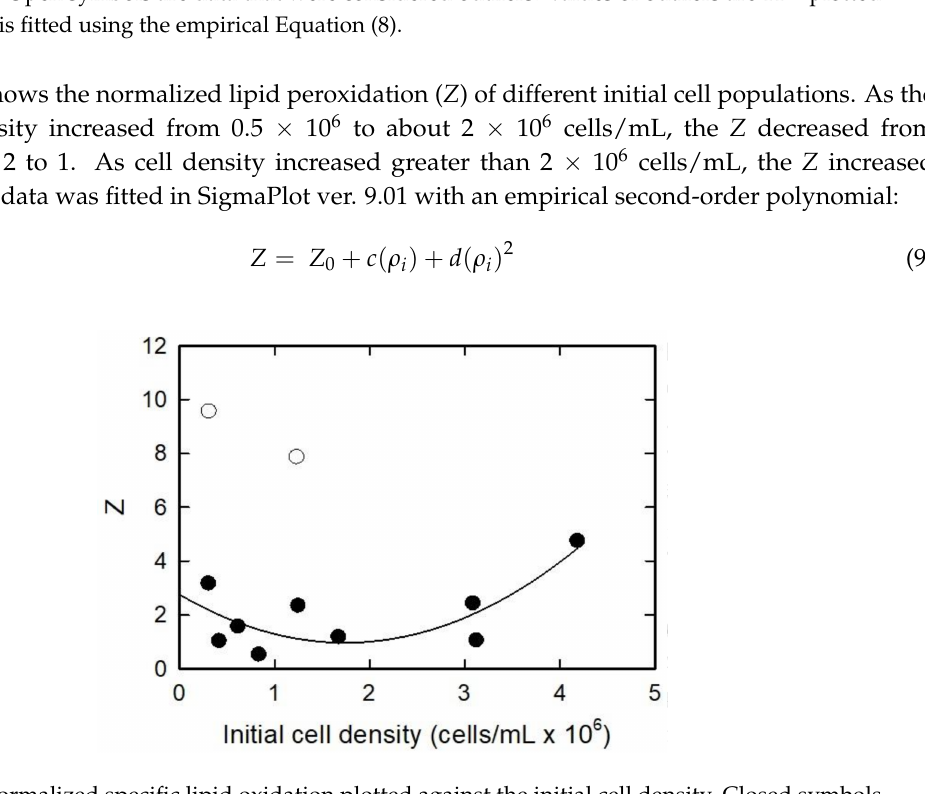
Figure 5. Normalized specific lipid oxidation plotted against the initial cell density. Closed symbols are fitted data points. Open symbols are data that were considered outliers and not included in the fitting. Line is fitted using the empirical Equation